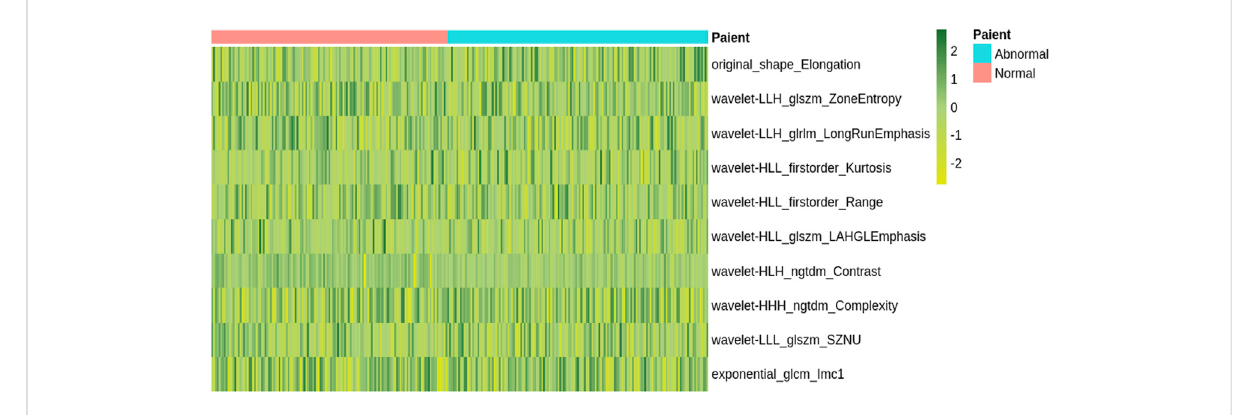
FIGURE 2 A heatmap shows the radiomic features. Each column and row correspond to one patient and z-score normalized radiomic feature, respectively.